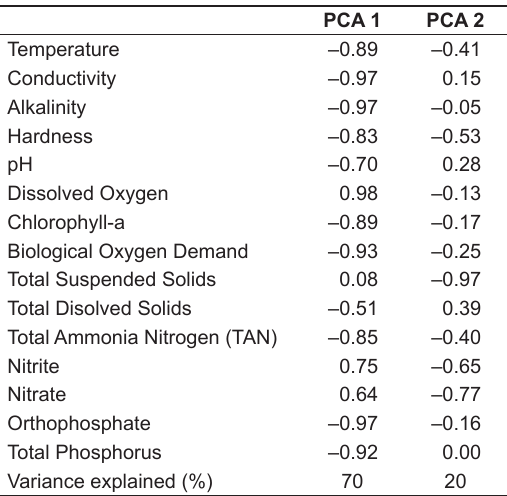
Figure 2. Monthly variation of total ammonia nitrogen (TAN), orthophosphate (OP), temperature (Temp), dissolved oxygen (DO) and nitrate (NO3) of the water samples sites (CC; WO; IW12; IW6; IWM) during the studied period. Table 2. Principal Component